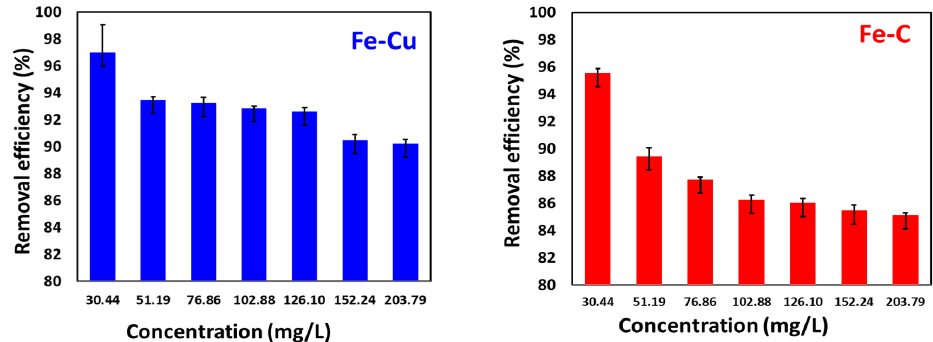
Figure 6. Effect of initial concentration CIP on CIP removal under Fe-Cu and Fe-C treatment.